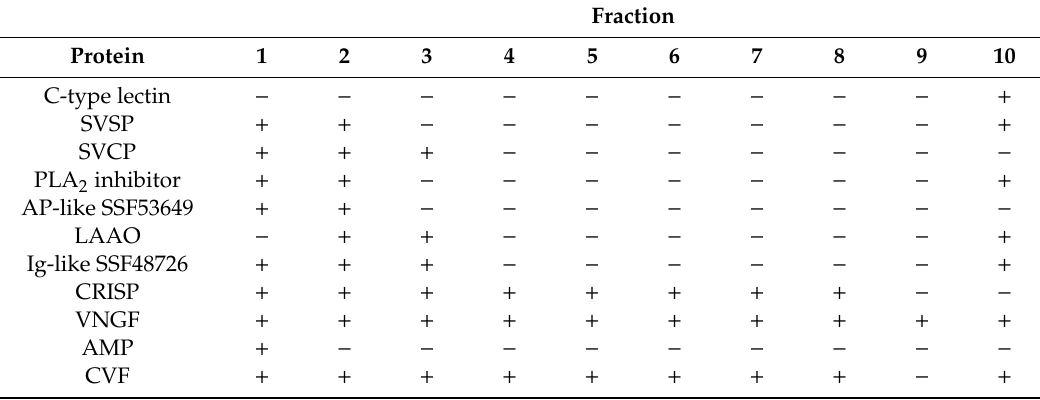
Table 1. Low abundant proteins in Naja ashei venom. ( + ) denotes fractions in which a given protein group was detected; ( − ) denotes fractions in which the presence of a given protein group was not